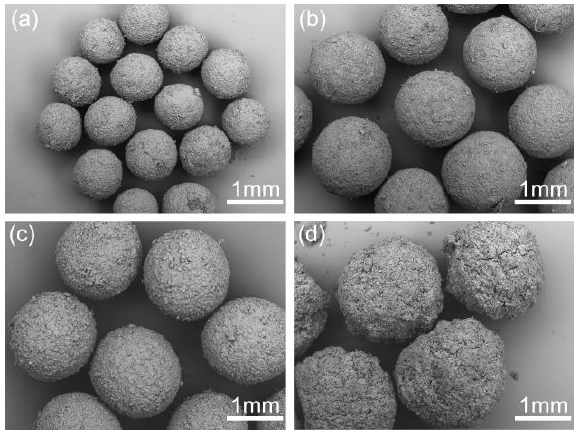
Figure 10. SEM images of the spherical crystals prepared at different concentrations: ( a ) 0.3 g/mL, SA-9; ( b ) 0.5 g/mL, SA-10; ( c ) 0.6 g/mL, SA-11; ( d ) 0.7 g/mL, SA-12.